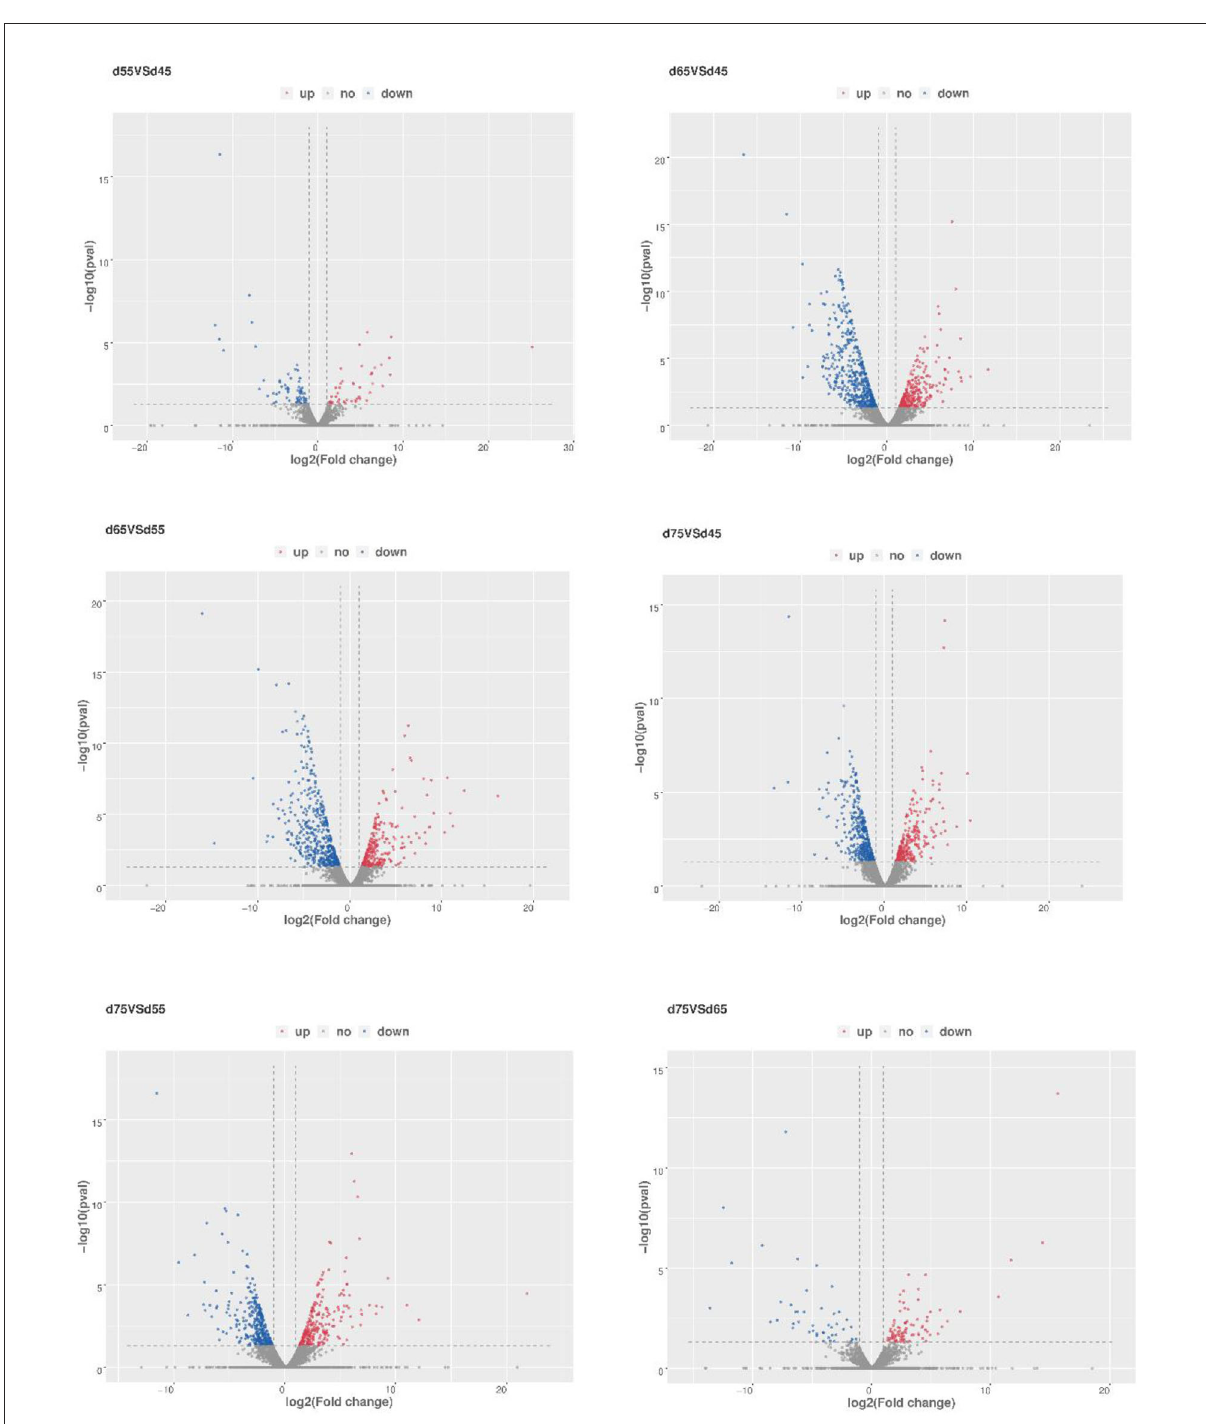
FIGURE5 Transcriptional analysis of differentially expressed lncRNA in different embryonic stages of Inner Mongolia cashmere goats. The blue dots represent differentially expressed and downregulated lncRNAs, the red dots represent differentially expressed and upregulated lncRNAs and the gray dots represent lncRNAs with no significant difference in